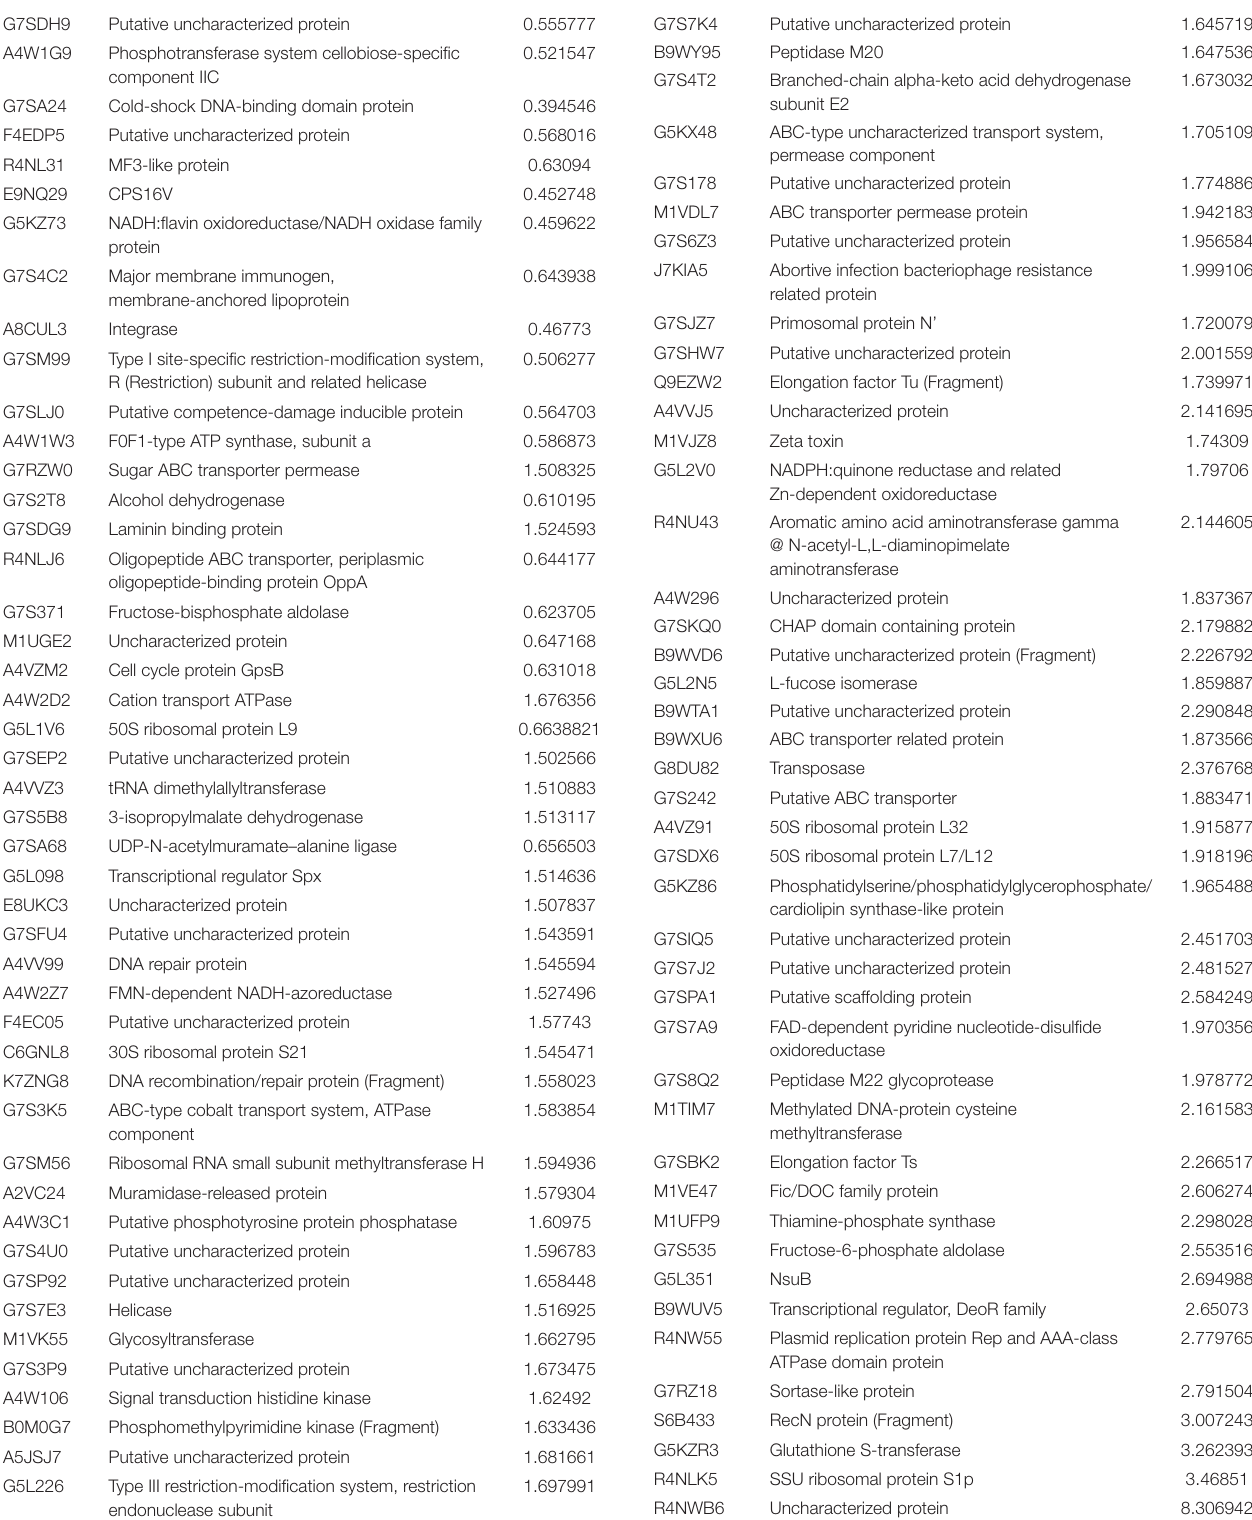
TABLE 1 | List of differentially expressed proteins in tylosin treated